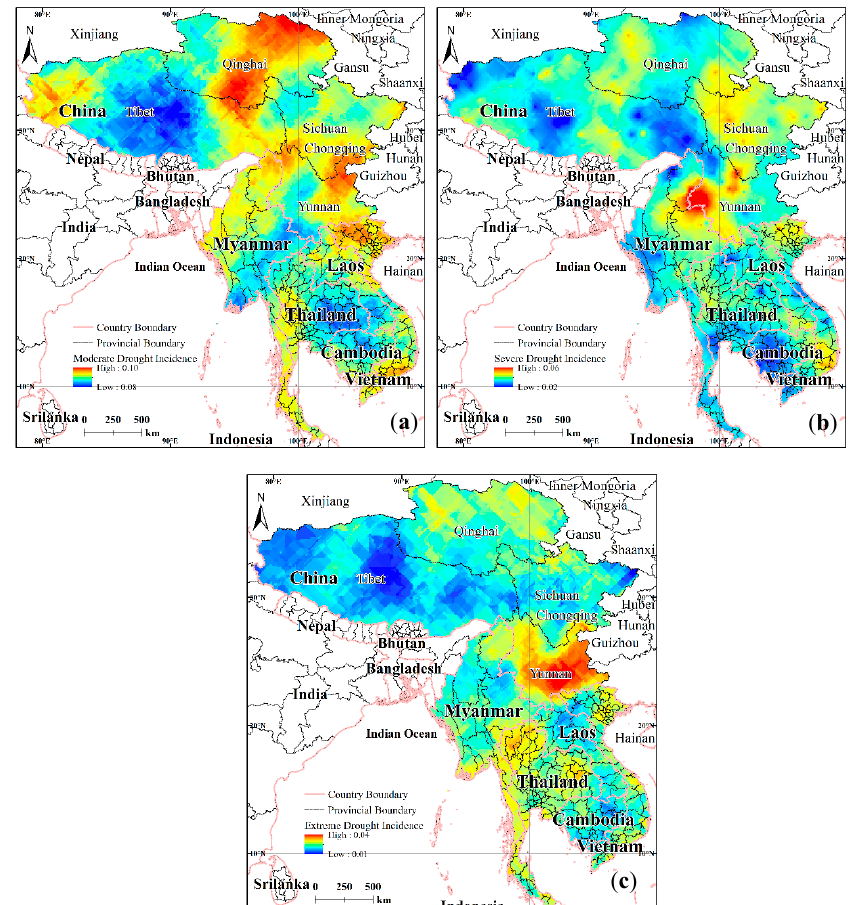
Figure 8. Spatial distributions for incidences of drought: ( a ) Moderate drought regions; ( b ) severe drought regions; ( c ) extreme drought regions.